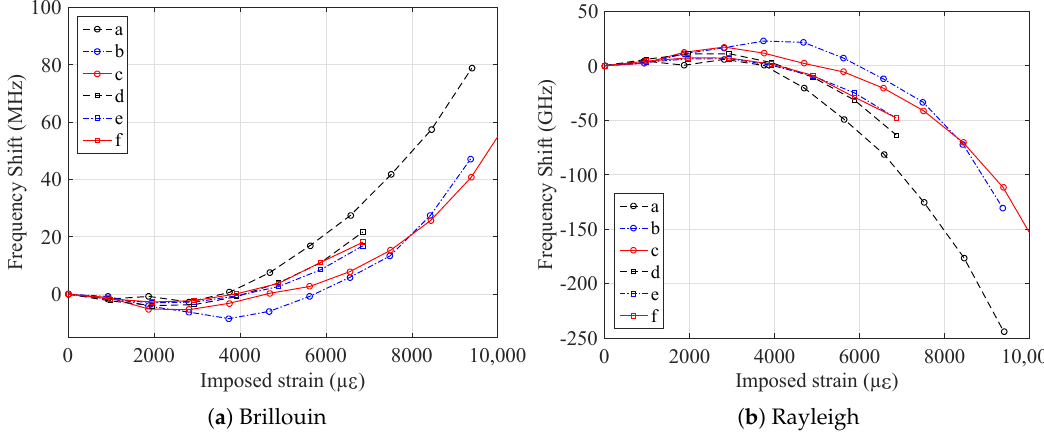
Figure 8. Residual frequency shift of the samples after elongation (represented in the x axis) of the cabled samples (V9 and FIMT) for the three tested types of condition (standard fiber, custom radiation hard fiber, and custom radiation hard fiber